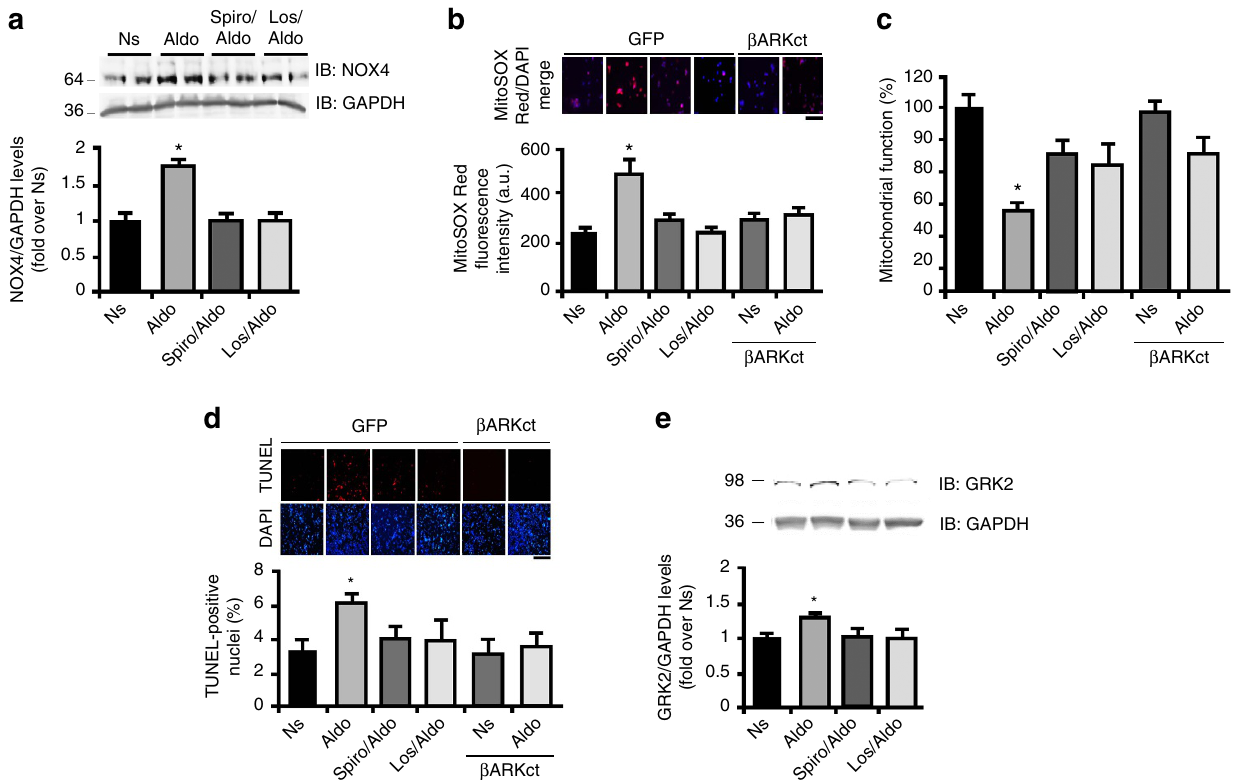
Figure 2 | Aldosterone induced oxidative stress and apoptosis. ( a ) Representative immunoblots (upper) and densitometric quantitative analysis (lower) of panels of multiple ( n ¼ 3) independent experiments to evaluate NOX4 protein levels in NRVMs unstimulated (Ns) or stimulated with Aldo (1 m M) for 15min. Before Aldo, a group of cells was pre-treated with Spiro (10 m M) or Los (10 m M) for 30min. GAPDH was used as loading control; * P o 0.05 versus Ns. ( b ) Representative panels (upper) and cumulative fluorescence data (bottom) from ( n ¼ 3) independent experiments of MitoSOX Red staining of NRVMs ( B 200 cells analysed for the group for each experiment) infected with adenoviruses encoding for either GFP or b ARKct. Myocytes were then Ns or stimulated for 30min with Aldo. Before Aldo stimulation, a group of GFP cells was pre-treated (30min) with Spiro (10 m M) or Los (10 m M); * P o 0.05 versus GFP Ns. Scale bar, 50 m m. ( c ) Bar graphs showing multiple ( n ¼ 3) independent experiment of MTTassay using NRVMs expressing b ARKct or GFP after Aldo treatment for 24h. Before Aldo stimulation, a group of GFP cells was pre-treated with Spiro (10 m M) or Los (10 m M) for 30min; * P o 0.05 versus GFP Ns. ( d ) Representative panels of TUNEL-positive myocytes (Red staining with blue DAPI staining) and quantitative data ( n ¼ 3 independent experiments) showing NRVM apoptosis ( B 1,000 cells analysed for the group for each experiment) induced by Aldo (1 m M for 24h) with Ad-GFP infection or Ad- b ARKct treatment. Before Aldo stimulation, a group of GFP cells was pre-treated with Spiro (10 m M) or Los (10 m M) for 30min; scale bar, 200 m m. * P o 0.05 versus GFP Ns. ( e ) Representative immunoblots (upper panels) and densitometric quantitative analysis (lower panel) of multiple ( n ¼ 3) independent experiments to evaluate GRK2 protein levels in NRVMs Ns or stimulated with Aldo (1 m M) for 12h. Before Aldo, a group of cells was pre- treated with Spiro (10 m M) or Los (10 m M) for 30min. GAPDH was used as loading control. * P o 0.05 versus Ns. ( a – e ) Statistical significance between groups was determined by one-way ANOVA with Bonferroni post hoc correction. All data are shown as mean ±